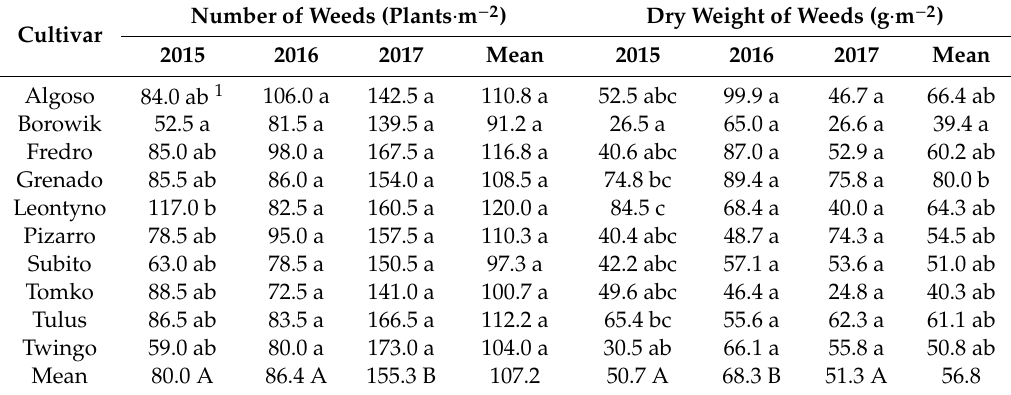
Table 3. Number and dry matter of weeds in triticale cultivars grown in the organic system at the dough stage.